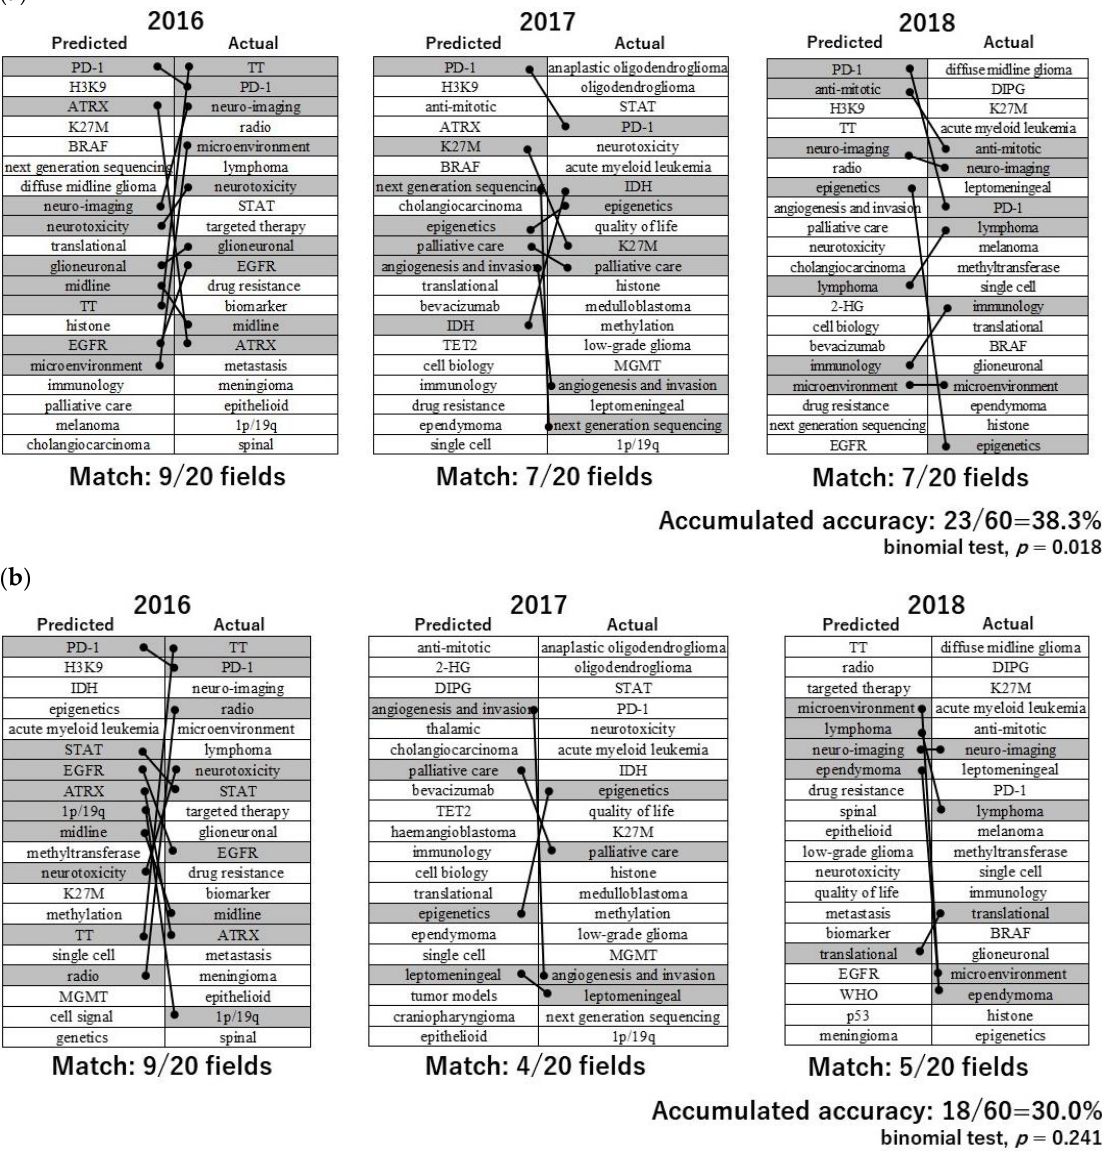
Figure 3. ( a ) The details of prediction with linear prediction using 5 years. The AII dataset to predict the top 20 fields with high ∆ -AII of 2 years after the data collection period. Predicted top 20 fields with high ∆ -AII are enumerated in left columns in order of expected ∆ -AII scores. Right columns are the year’s actual top 20 fields with high ∆ -AII in order of actual ∆ -AII scores. Fields matching the prediction are connected by lines. The accumulated accuracy means Accuracy C of linear prediction of Table 2. ( b ) The details of prediction with quadratic polynomial. Other analytical conditions are the same as Figure 3a. Fields matching the prediction are connected by lines. The accumulated accuracy means accuracy C of quadratic polynomial of Table 2.